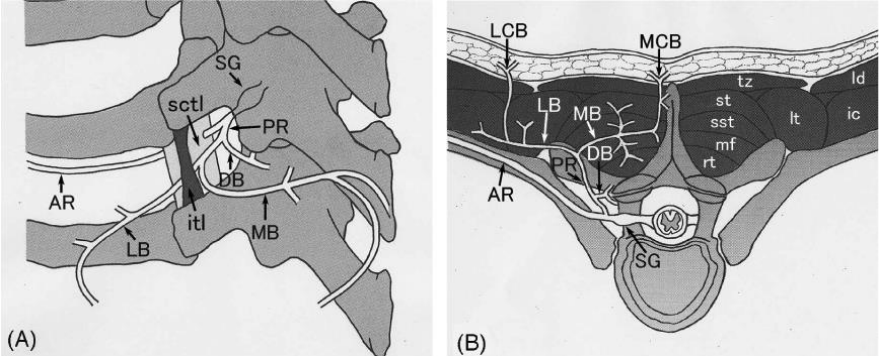
Figure 2. Illustration demonstrating the configuration of the posterior rami in the posterolateral ( A ) and axial ( B ) views. Note the cutaneous branches branching off at roughly right angles in the